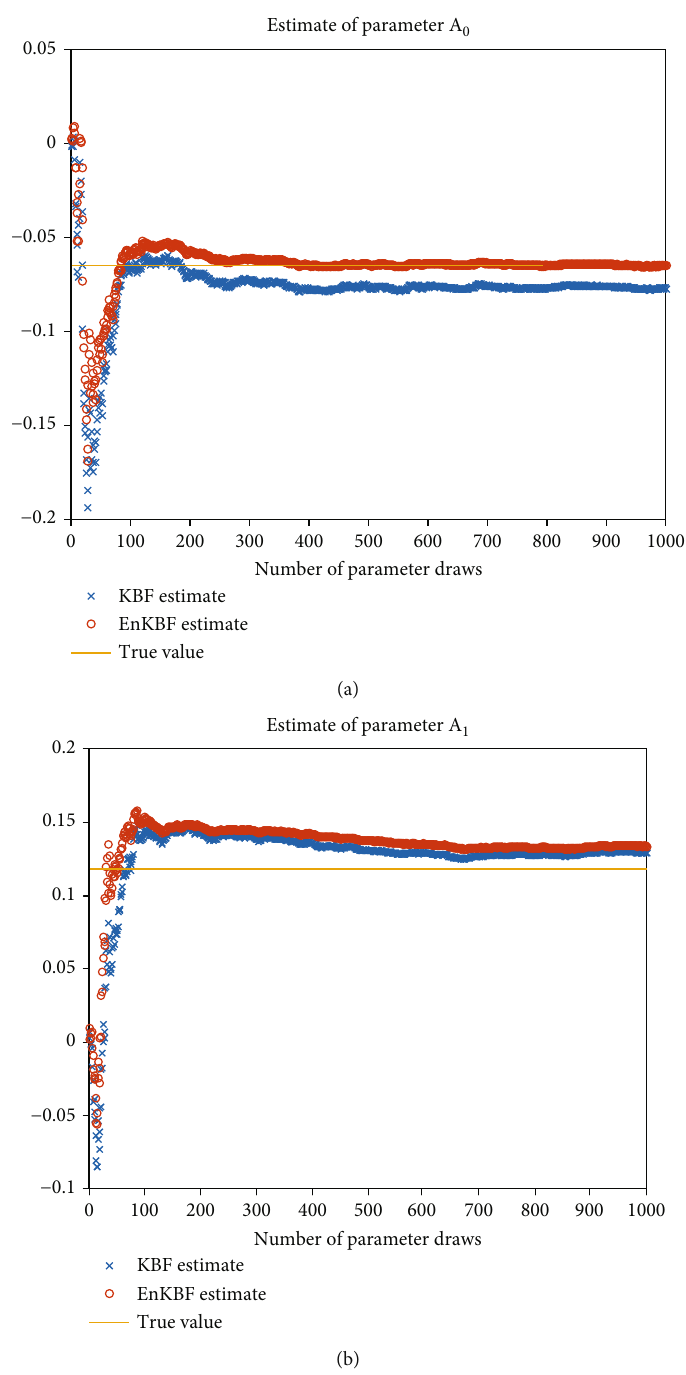
Figure 7: (a, b) are plots for velocity parameters for the fi rst two parameters in λ obtained using KBF-EnKBF and EnKBF dual fi lters, applied to the advection equation, both run for 1000 time steps. The number of particles, for the state and hyperparameters, used in EnKBF is M = 1000 and L = 1000 ; the time step size used in both fi lters is dt = 0 : 01 . μ = 0 : 001 and 100 grid points are used. Compared